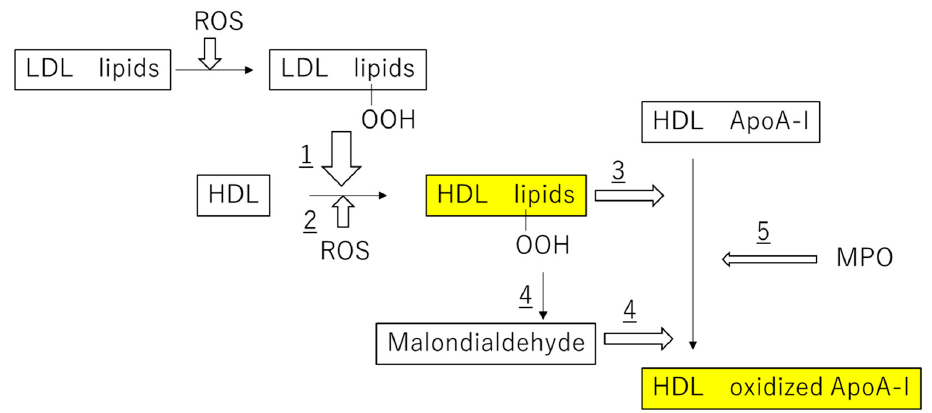
Figure 1. Increased oxidation of lipid components and ApoA-I in high-density lipoprotein (HDL)